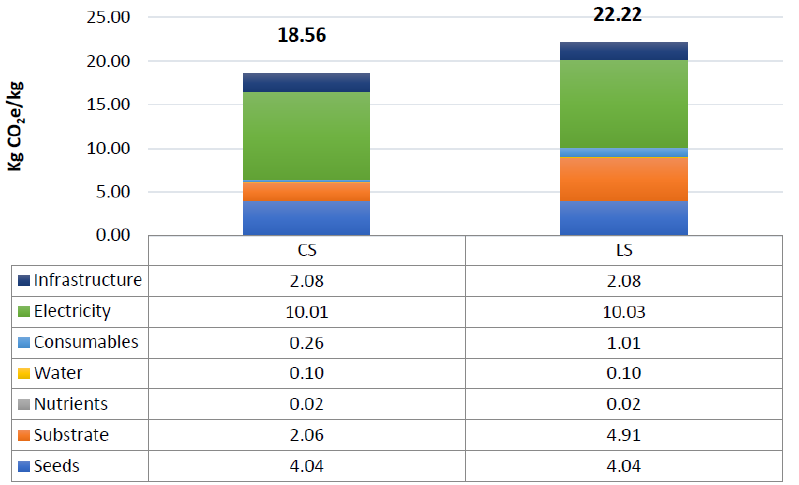
Figure 2. Global Warming Potential results of the LCA model of the building-integrated IVF technol- ogy for Circular Supply (CS) and Linear Supply (LS) scenarios. Presented in carbon emissions CO 2 e/kg per kg of fresh weight broccoli microgreens for material inputs.